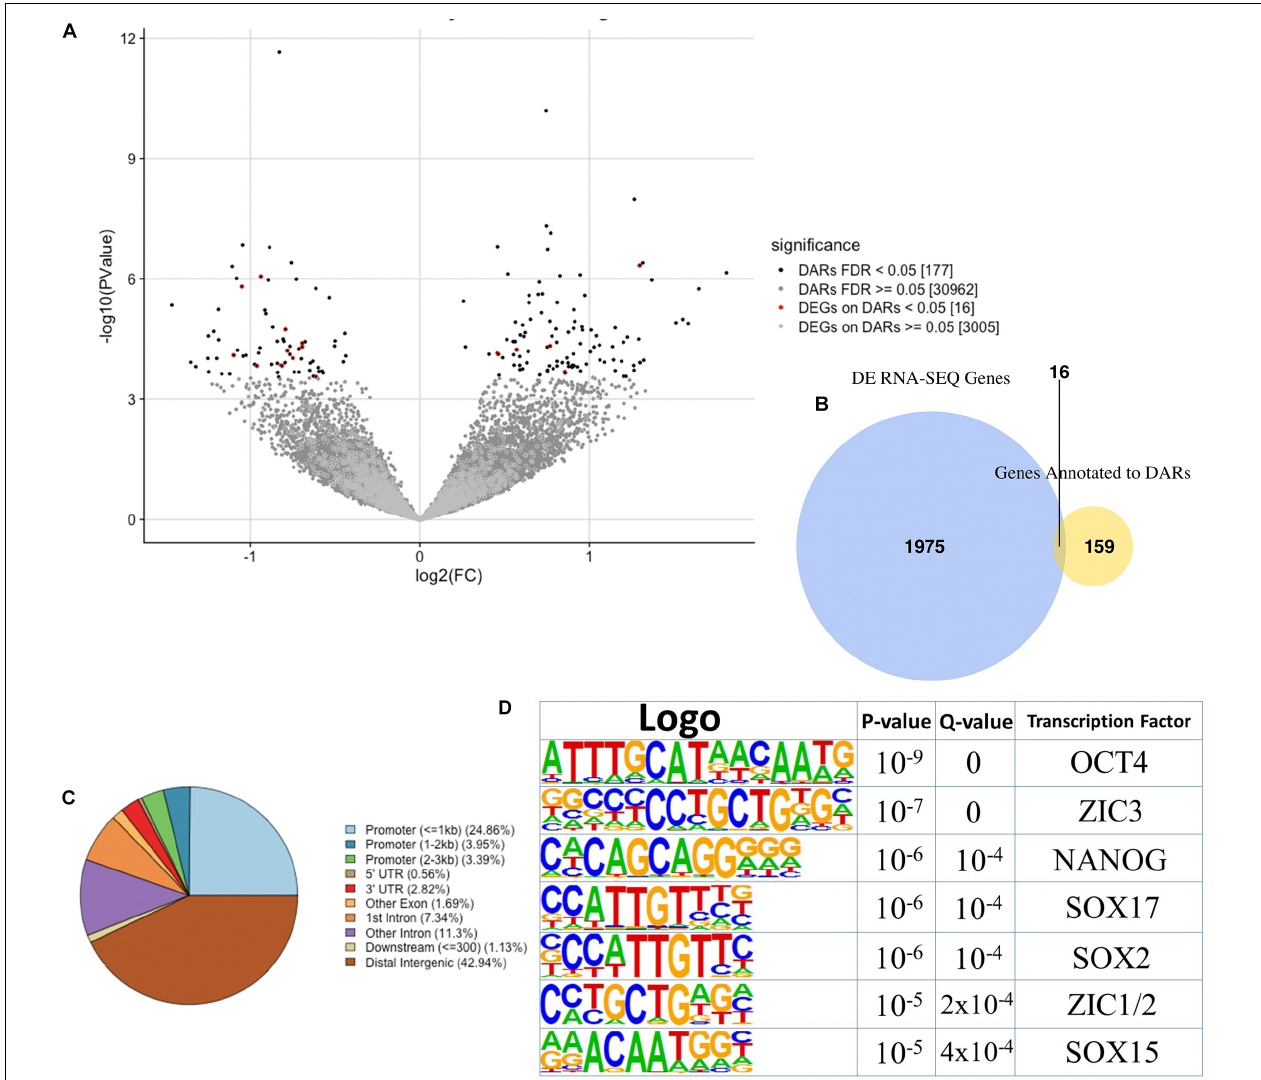
FIGURE 3 | Analysis of differentially accessible regions (DARs) in Tbx1 KD vs. control P19Cl6 cells. (A) Volcano plot of all peaks. Regions with significantly different accessibility are indicated as black dots. Red dots indicate DARs associated with differentially expressed genes (DEGs). (B) The Venn diagram intersects DEGs with genes associated with DARs. There were 16 genes in common between the two groups. (C) Pie chart showing the distribution of the 177 DARs relative to gene features. Note the reduced representation of promoter regions and a relatively higher representation of distal intergenic regions compared to the general populations of peaks shown in Figure 2C . (D) Logos of the most significantly enriched motifs detected in the 177